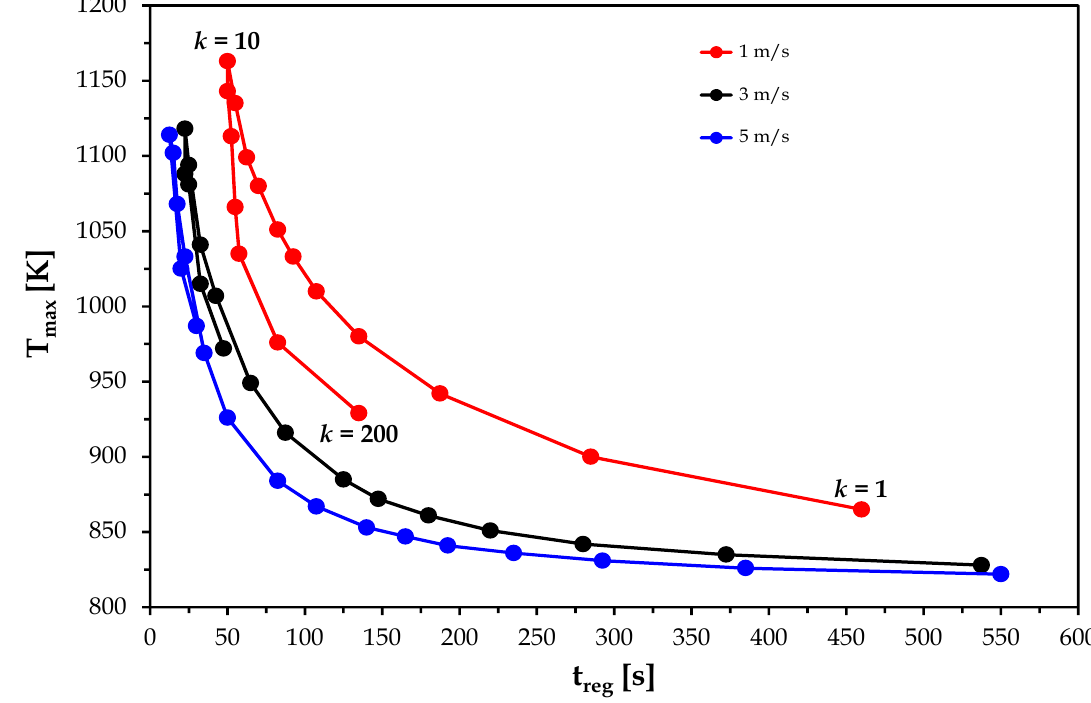
Figure 10. Operating map of the filter in the plane T max versus t reg : simulations run by varying the catalyst activity, k , at di ff erent inlet gas